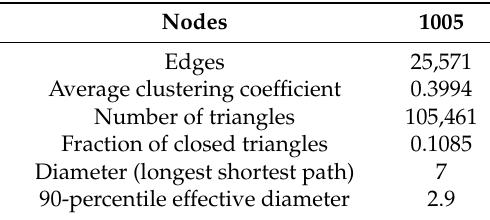
Figure 10. GUI (Graphical User Interface) layout of the Pareto Defense Strategy Selection Simulator (PDSSS) system. Table 5. Dataset statistics. Table 5. Dataset statistics.